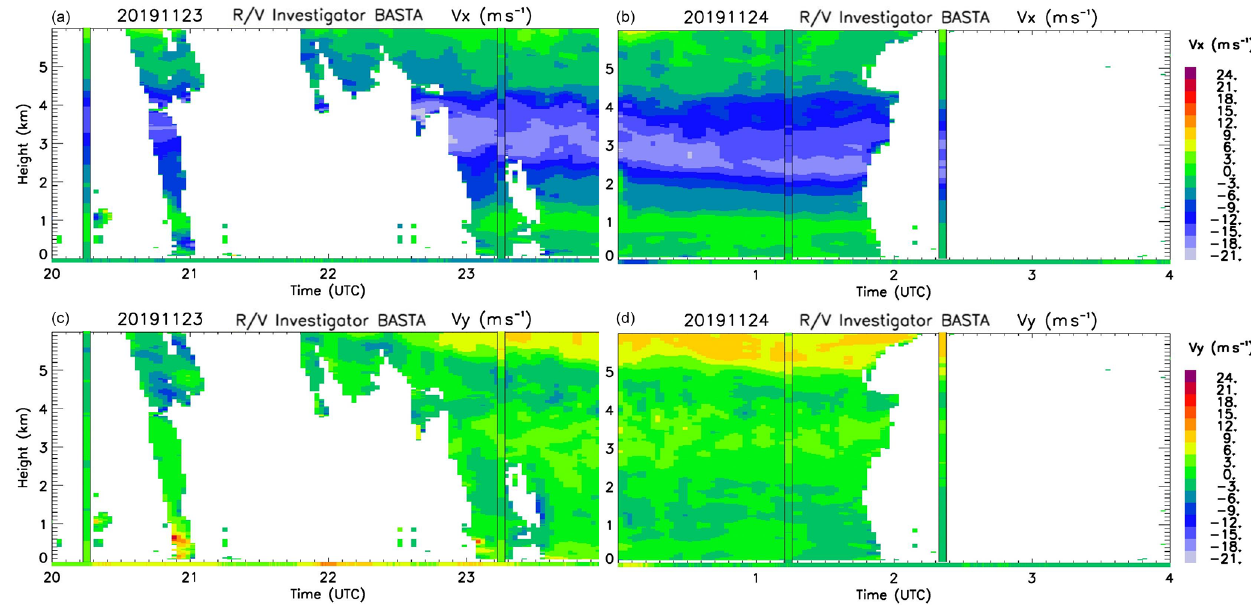
Figure 2. Time–height cross section of retrieved (a, b) V X and (c, d) V Y in the same case as Fig. 1 but for a maximum altitude of 4km. The horizontal winds measured on the front mast of RV Investigator are displayed at height = 0 with the same colour scale as the retrieved